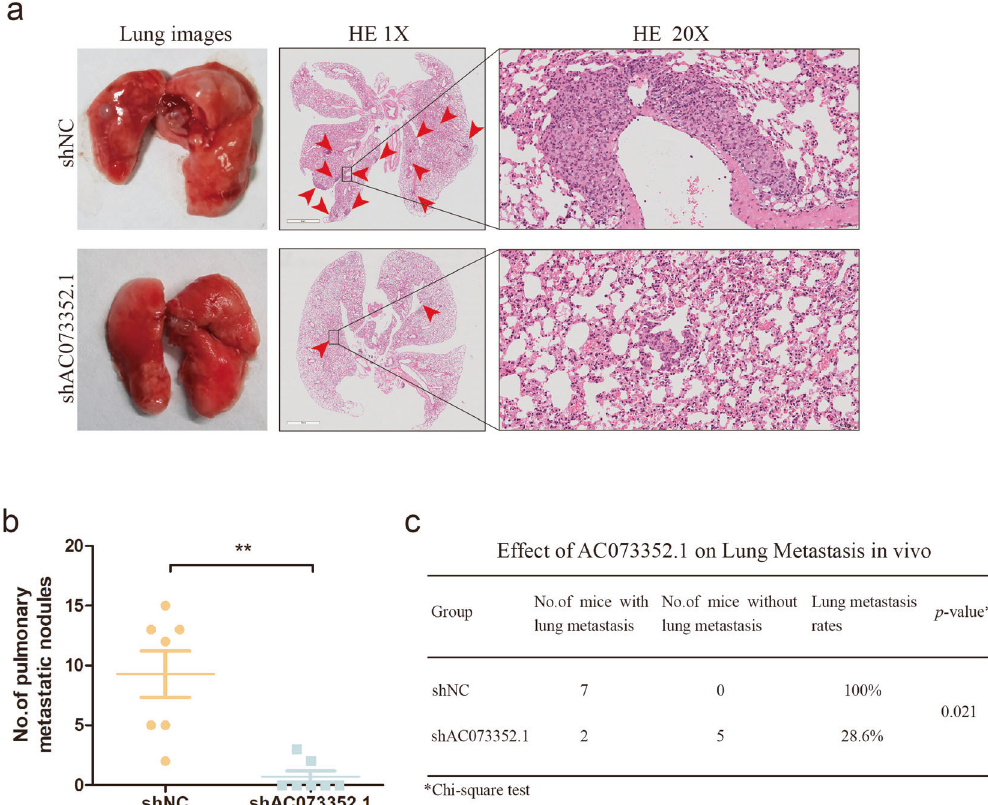
Fig. 3 AC073352.1 accelerates breast cancer metastasis in vivo. a The representative images of lung metastasis of mice. Hematoxylin and eosin (HE) staining of lungs were removed from mice injected with shNC or shAC073352.1 stable cell line. b Metastasis nodules were counted and analyzed using Student t test. Values are expressed as mean ± SEM. c The ratio of lung metastasis was calculated for the indicated groups. The p value was determined using χ 2 test. * p < 0.05 and ** p <